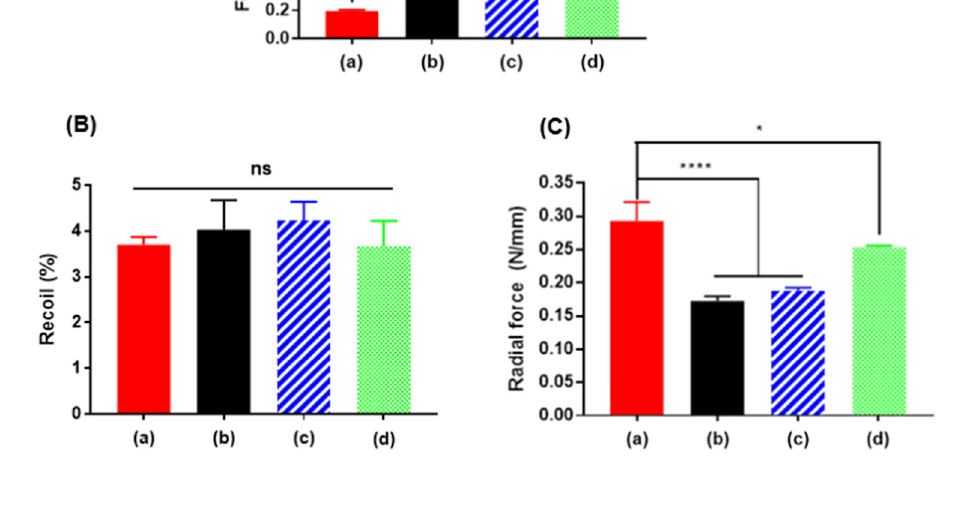
Fig. 4 Trackability ( A ) and dislodgement force test ( B ) of D + Storm ® DES (Drug-eluting stent) (a), Synergy ™ (b), Orsiro ® (c), and Xience sierra ™ (d)